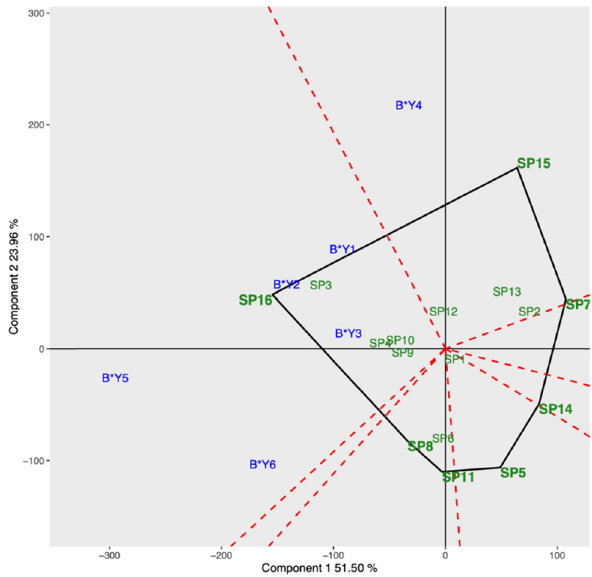
Figure 8: The genotype by yield*trait ( GYT ) biplot “ which - won - where/what ” of the honey sweet potato genotypes in multiloca - tion